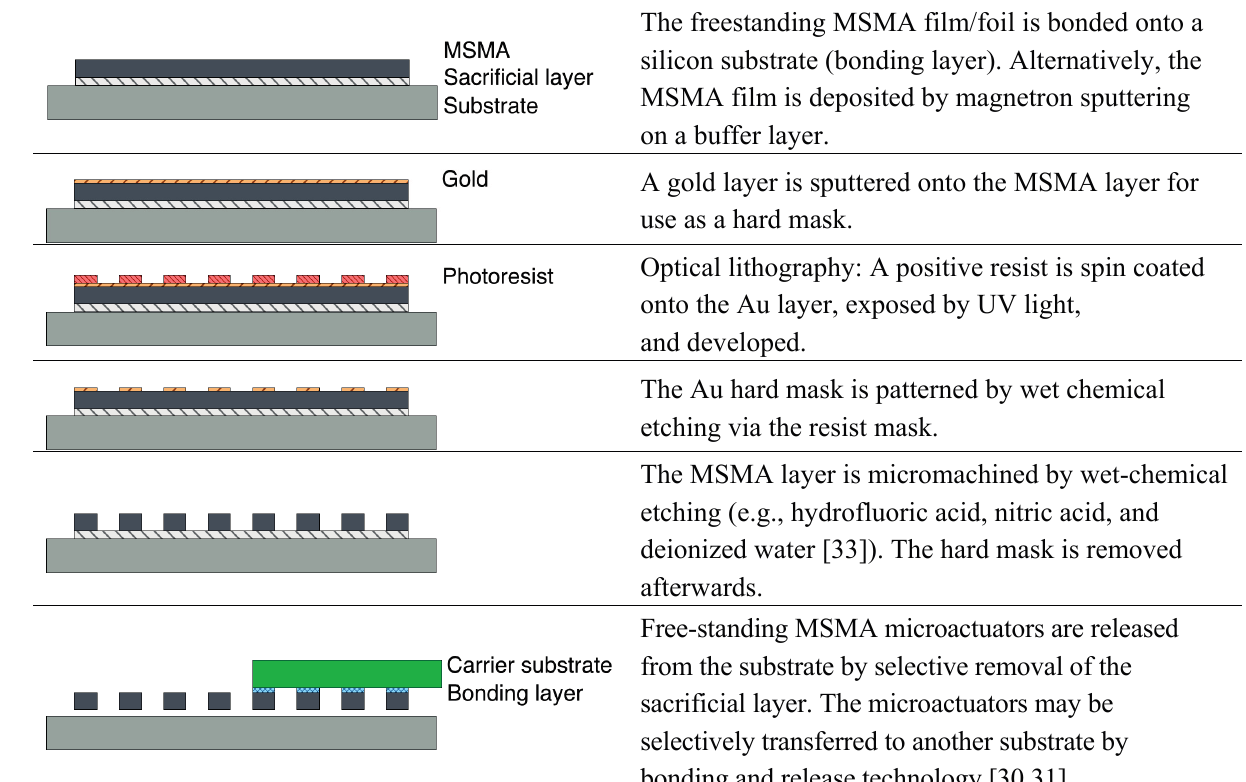
Table 1. MEMS-compatible process flow for fabrication of (magnetic) shape memory alloys ((M)SMA)